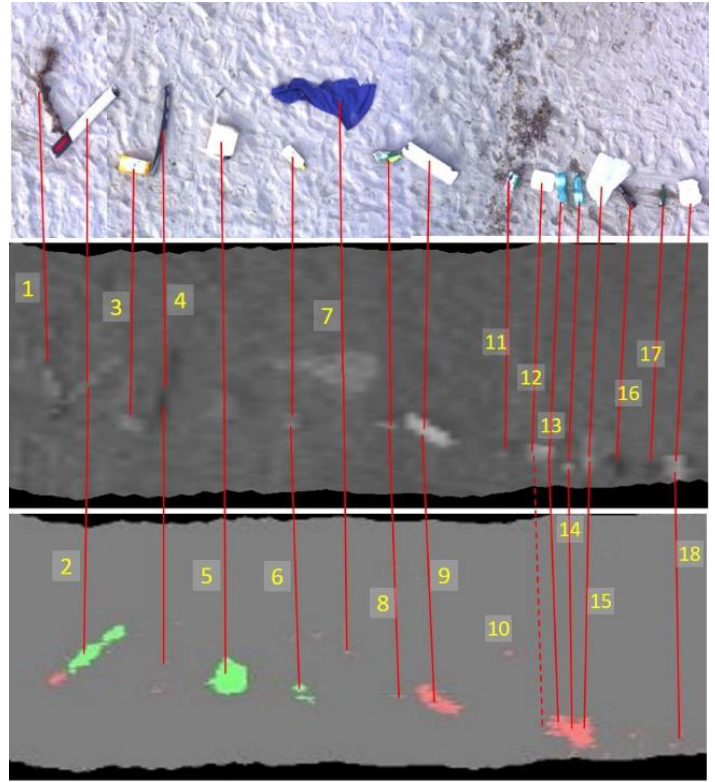
Figure 14. Detection of plastic objects on Platamona beach: (1) Wood; (2) way marker post, of unknown plastics; (3) unknown plastics wrapper; (4) PVC pipe; (5) unknown plastics canister; (6) HDPE bottle; (7) cloth; (8) soft plastics container; (9) PET plastics container; (10) false positive; (11) metal cans; (12) PS container; (13, 14) PET bottles; (15) unknown plastic wrapping; (16, 17) glass bottles; (18) Styrofoam.